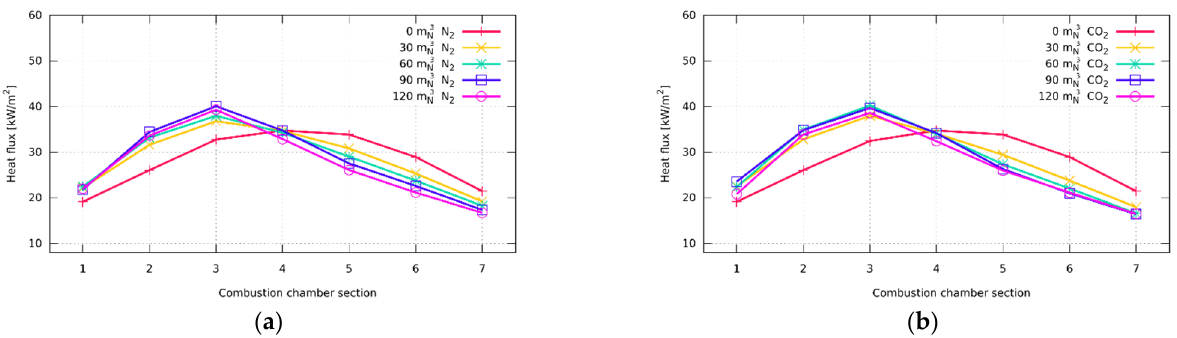
Figure 13. Influence of inert gas addition on heat flux distribution—low-calorific burner—Burner C: ( a ) addition of N 2 ; ( b ) addition of CO 2 .